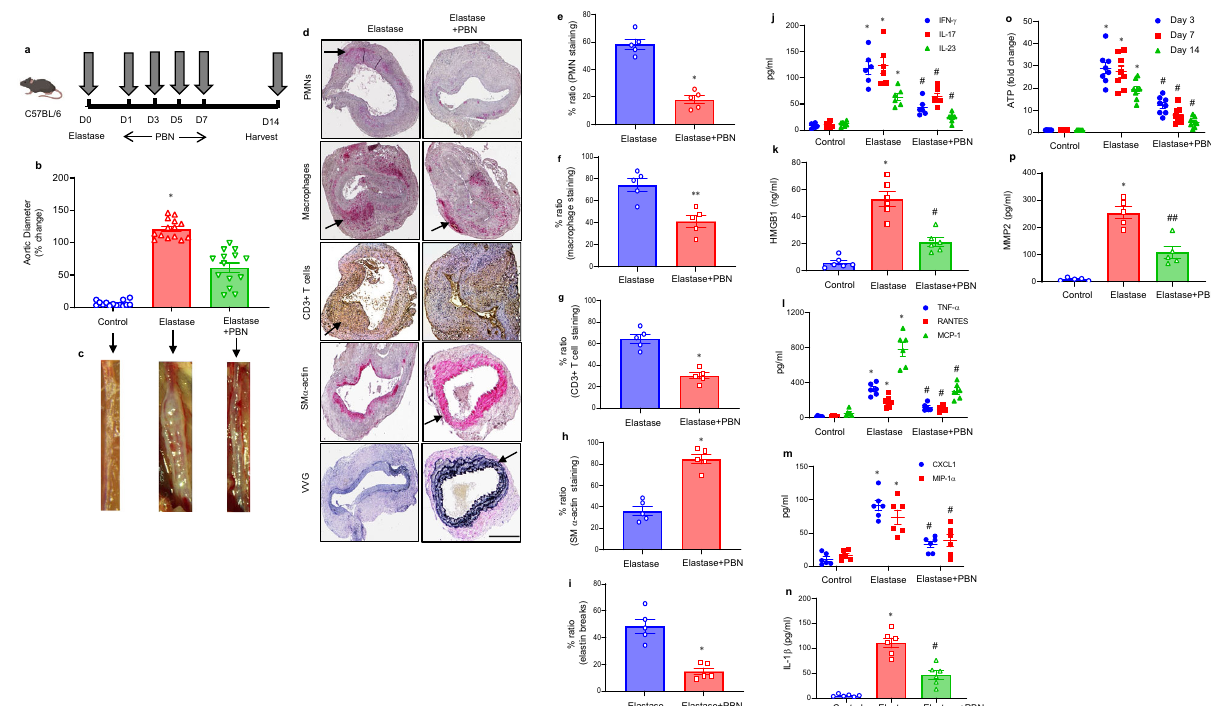
Fig. 3 Pharmacological inhibition of Panx1 mitigates AAA formation in the elastase-treatment model. a Schematic depicting treatment protocol for probenecid (PBN) in the elastase model of AAA. b PBN treatment attenuates aortic diameter in elastase-treated male WT mice compared with elastase treatment alone. * P = 0.0001 vs. all other groups; n = 14/group. c Representative images of aortic phenotype in the respective groups. d – i Comparative histology displayed a marked decrease in leukocyte in fi ltration and elastin- fi ber disruption, as well as increase in SM α -actin expression in PBN-treated mice compared with elastase-treated mice alone.* P = 0.007; ** P = 0.01; n = 5/group. Arrows indicate areas of immunostaining. Scale bar is 400 μ m. j – n Pro- in fl ammatory cytokine expression in aortic tissue is signi fi cantly attenuated in elastase-treated WT mice after PBN administration compared with elastase- treated mice alone. * P < 0.0001 vs. respective controls; # P < 0.001 vs. elastase.; n = 6/group. o A signi fi cant decrease in aortic tissue ATP content was observed in PBN-treated mice compared with elastase-treated mice alone. * P < 0.0001 vs. controls; # P < 0.0001 vs. elastase; n = 8 mice/group. p Expression of MMP2 in aortic tissue was signi fi cantly attenuated in PBN-treated mice compared with elastase-treated mice alone. * P < 0.0001 vs. control; # P = 0.0003 vs. elastase; n = 5/group. Data are represented as mean values ± SEM and comparative statistical analyses were done by one-way ANOVA followed by multiple comparisons. Source data are provided as a Source Data fi